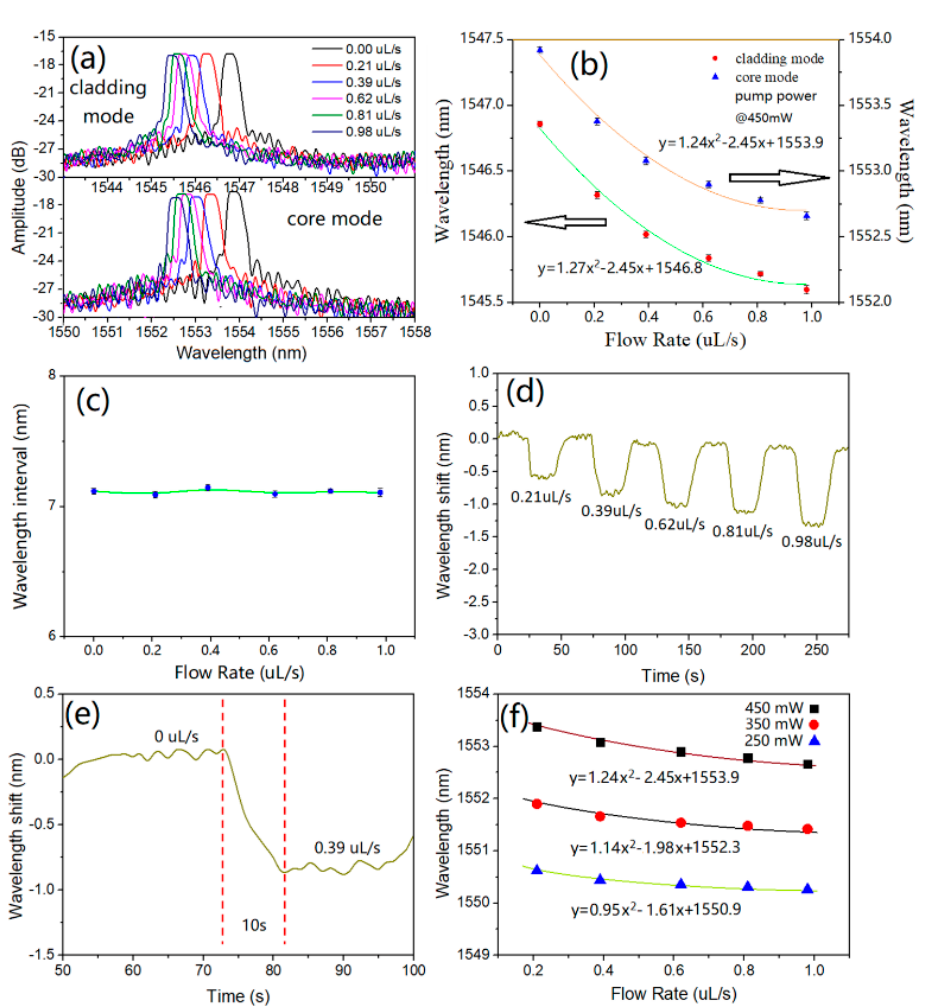
Figure 4. ( a ) The reflection spectra of cladding mode and core mode at different LFRs; ( b ) wavelength change of λ a and λ b ; ( c ) wavelength change of λ a–b ; ( d ) the experimental process; ( e ) the time response; ( f ) wavelength shift of λ a with different pump laser powers.